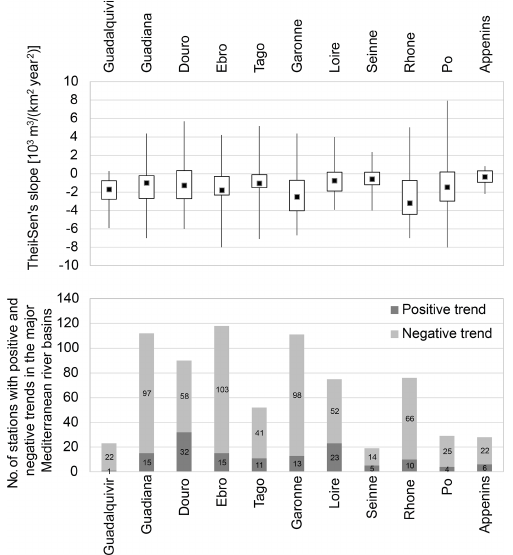
Figure 7. Number of stations with positive and negative annual streamflow volume trends in the main Mediterranean river basins. The box plot of the Theil–Sen slope for each catchment is also re- ported.